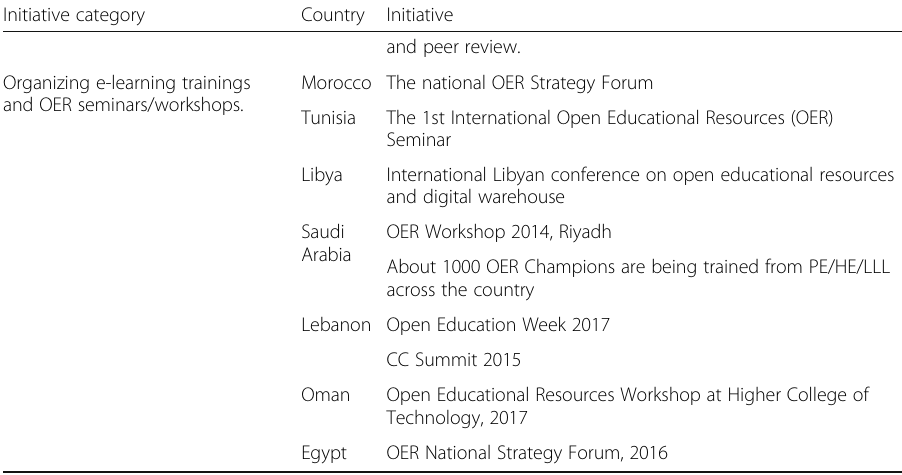
and peer review.